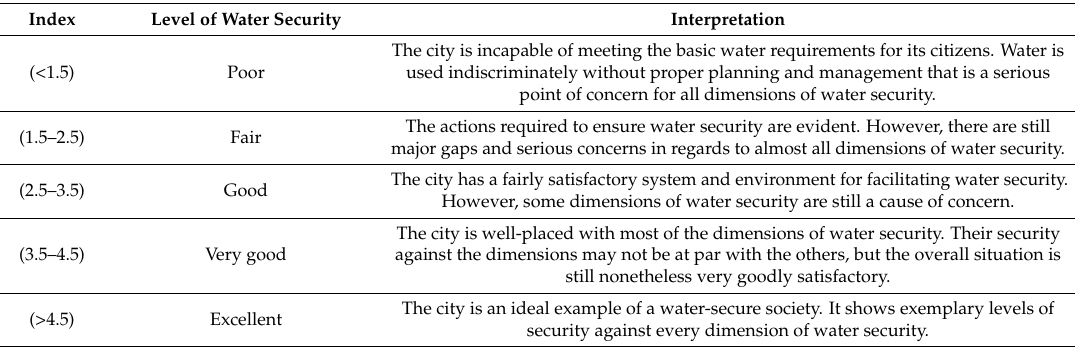
Table 3. Interpretation of the domestic water security index